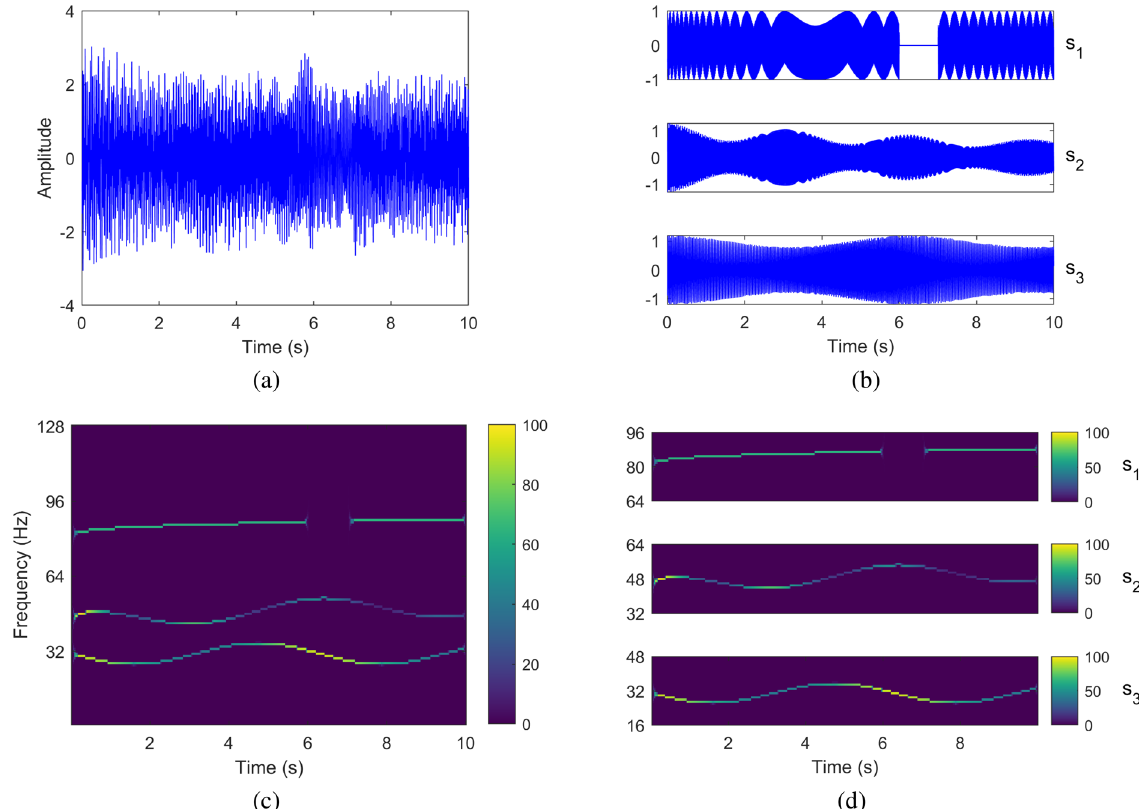
Figure 1. Example of SD and T–F representation of a signal. The original composite signal is shown in the time domain in ( a ) and its separate components, s 1 , s 2 & s 3 are shown in ( b ). In ( c ) the T–F representation is shown for the composite signal. In (d), the time-frequency representation of each of the separate components of the original signal is